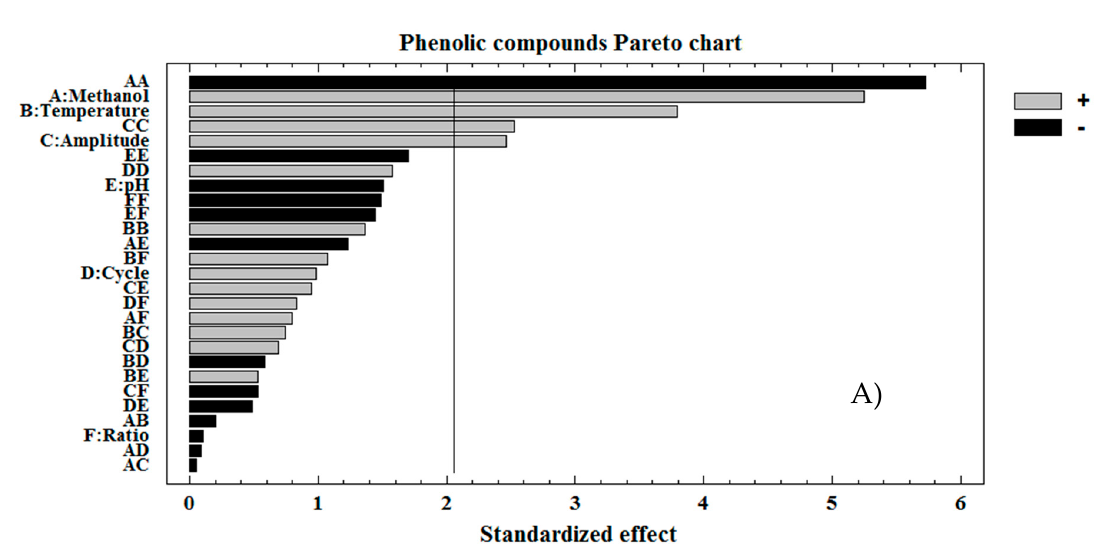
Figure 1. Standardized Pareto Charts for total phenolic compounds.